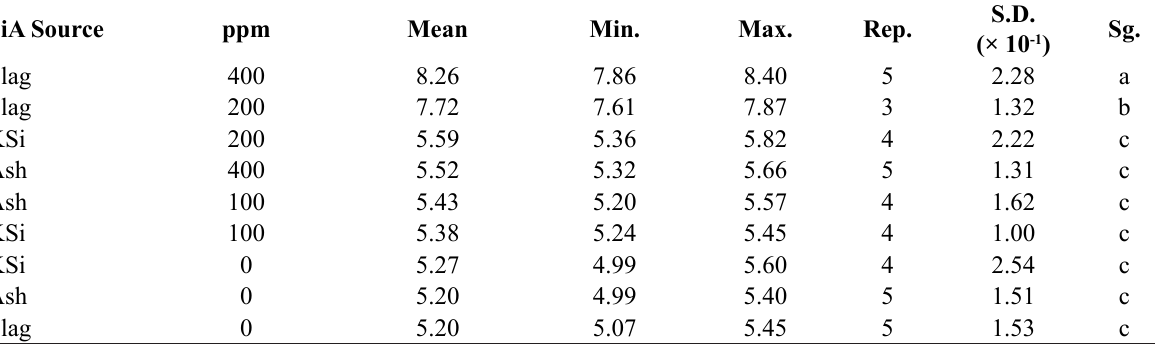
Table 4. S tatistical summary of soil pH data at the end of the campaign. Significance levels were obtained with Tukey test, α = 0.05.